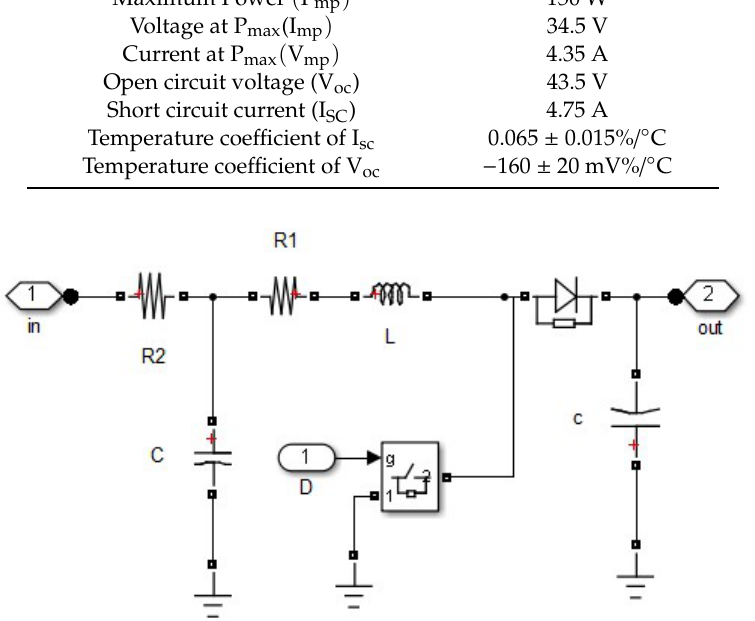
Figure 6. Simulink model of the boost converter.